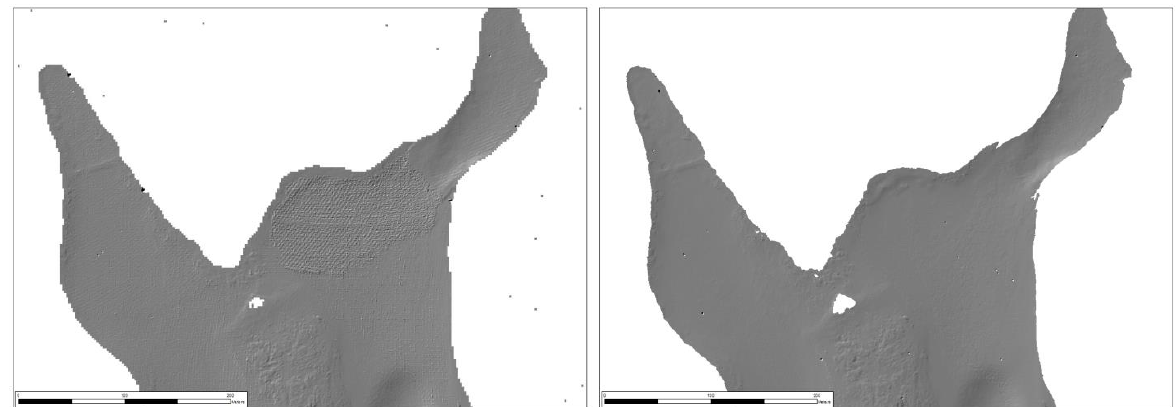
Figure 5. Hillshade of underwater DTM derived from the unfiltered last echo point cloud without (left image) and with (right image) strip